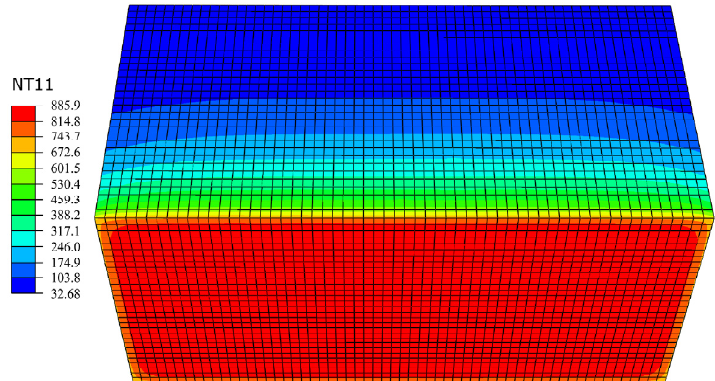
Figure 14. Temperature field cloud diagram of the SFRC specimen (°C).